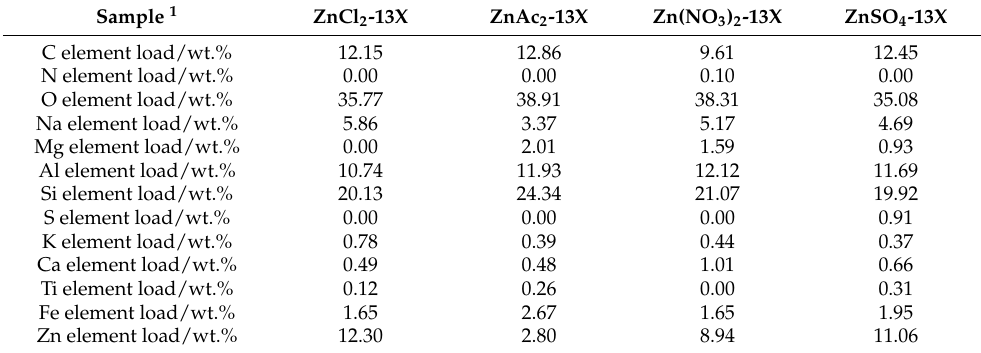
Table 2. Elemental composition after modification of 13X with different zinc salts.